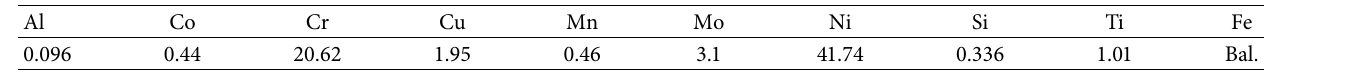
Table 2: Chemical composition of the Incoloy825 (mass percentage).